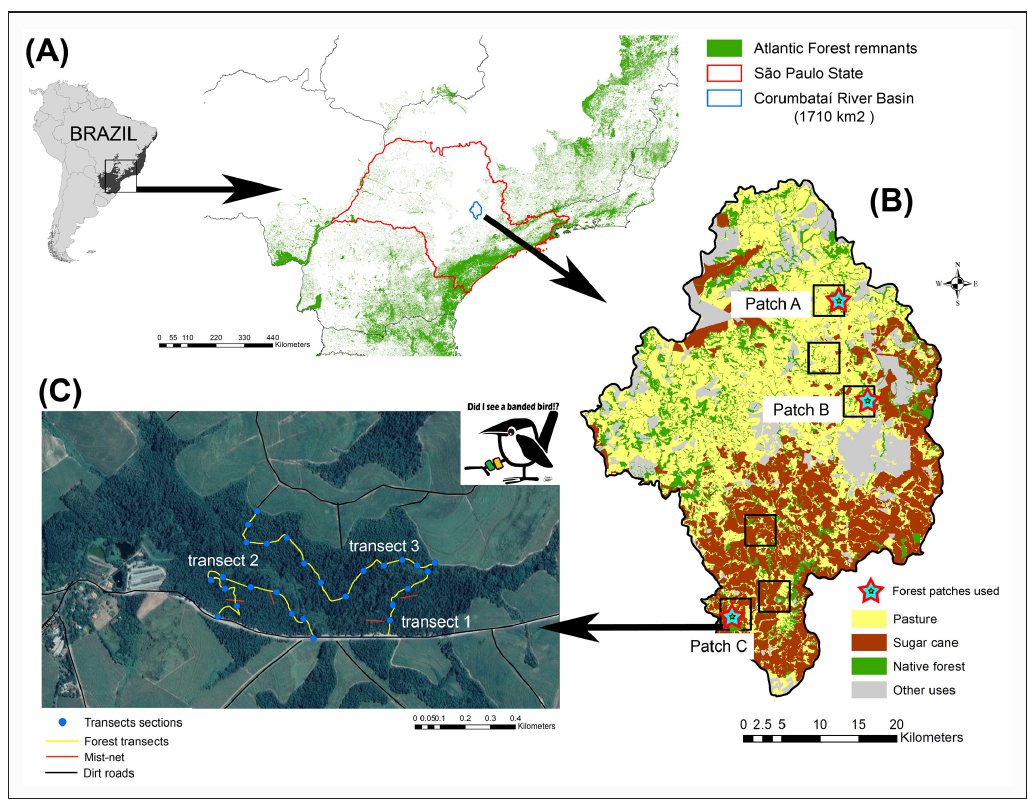
Figure 2: A) Location of the Corumbataí River Basin in southeastern Brazil in São Paulo state. Only a few remnants of the original cover of the Atlantic forest biome (dark grey in 2a) are left after years of human impact. B) Now, Corum- bataí River basin is predominantly an agricultural landscape. Black squares are focal landscapes used by research since 2011, composed of 70% of matrix and 10% of native forest. Three forest patches were originally targeted for this project, but only patch “C” was used. C) The Santa Olímpia forest patch, where our project “Did I see a banded bird?” was carried out. The forest patch lies within a sugarcane matrix. Birdwatching transects (yellow) were subdivided into sections (blue points) of 150 meters. Red lines represent mist netting stations for bird banding. Satellite image from Google Earth. Project logo was created by Luccas Longo, reproduced here with his